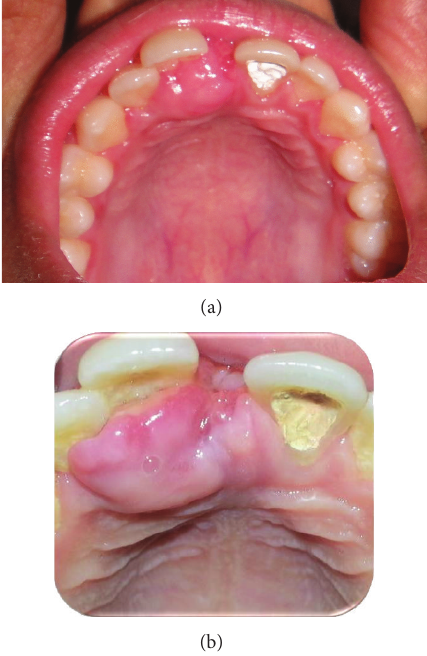
Figure 2: Well-defined enlargement on the palatal aspect of 11, involving the marginal and attached gingiva, and extending into the midline area.